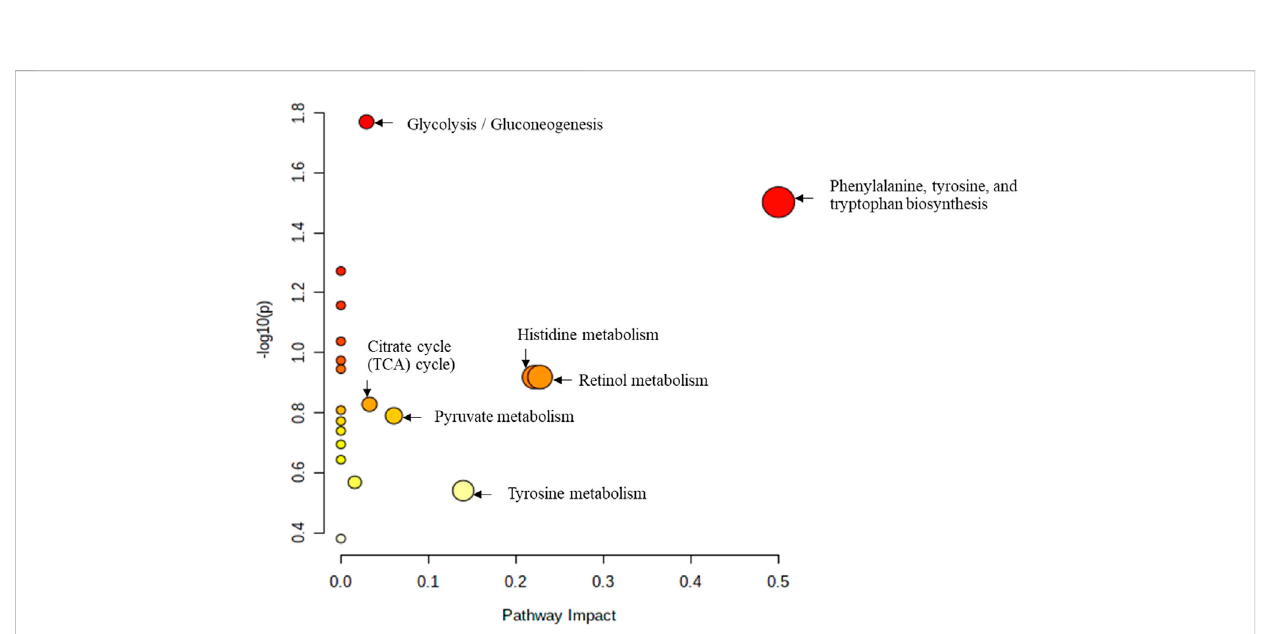
FIGURE 6 Metabolic pathways associated with the top 15 identi fi ed metabolites mark-ers. All the matched pathways are displayed as circles. The node size is proportional to the enrichment ratio. Light yellow to red indicates the p -value from small to large. The color and size of each circle are based on the p -value and pathway impact value, re-spectively. The most impacted pathways having high statistical signi fi cance scores are indicated with their